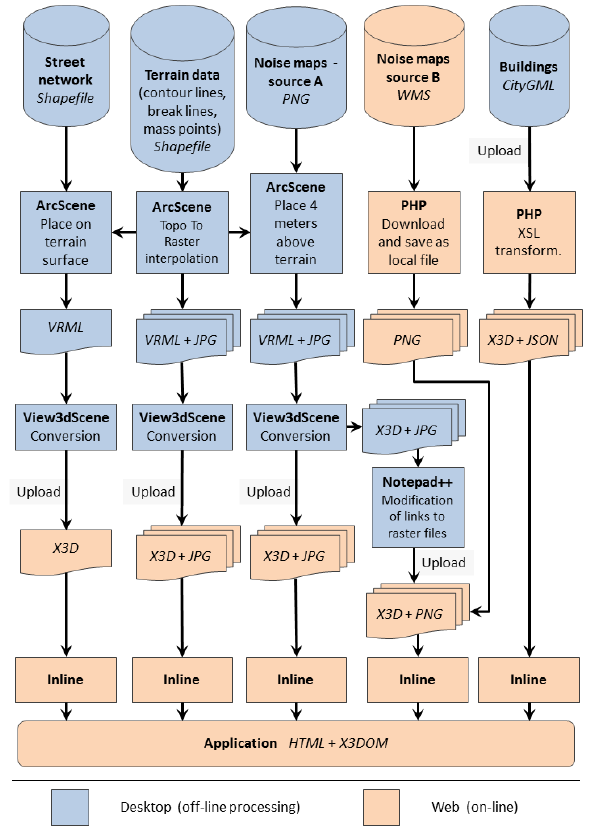
Figure 4. Workflow of data processing